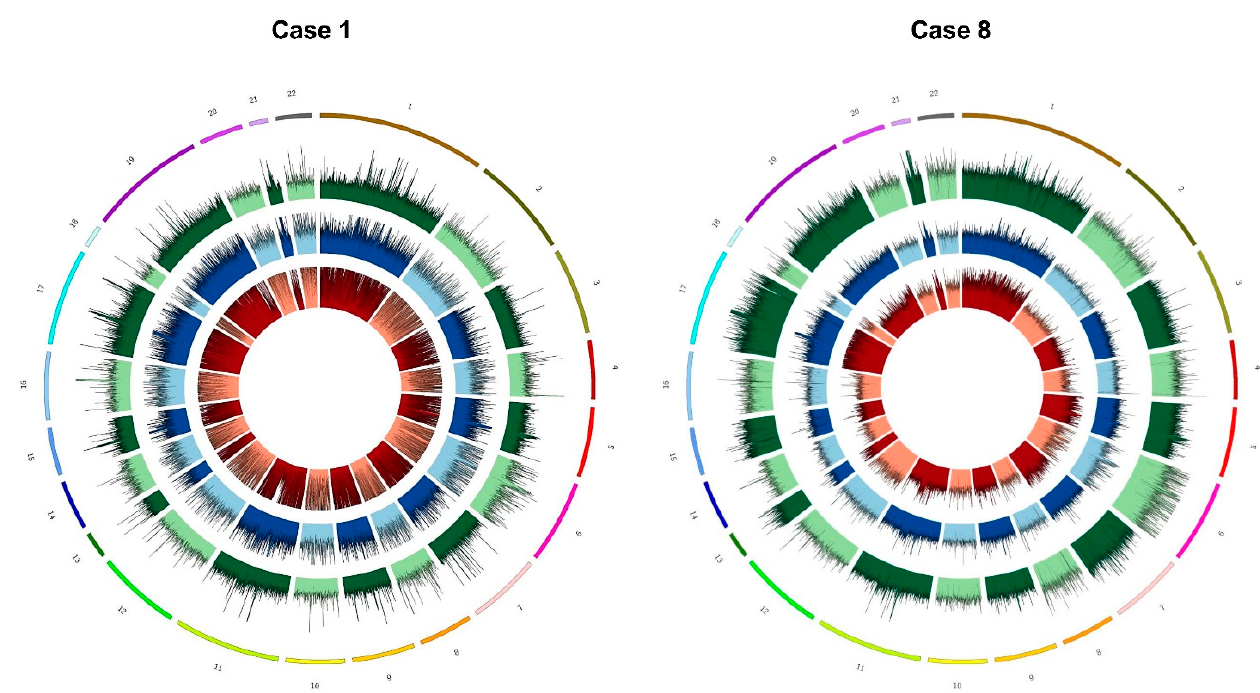
Figure 2. Circular view of chromosomes coverage for two representative cases. Each color represents a different DNA specimen: Tumor DNA (red), exo-DNA at onset (blue), exo-DNA at relapse (green).